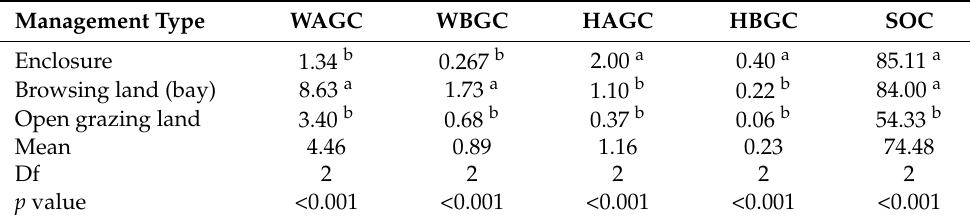
Table 2. Variation in the carbon stocks (t C ha -1 ) from the five compartments (above- and belowground herb, above- and belowground tree, and soil organic carbon